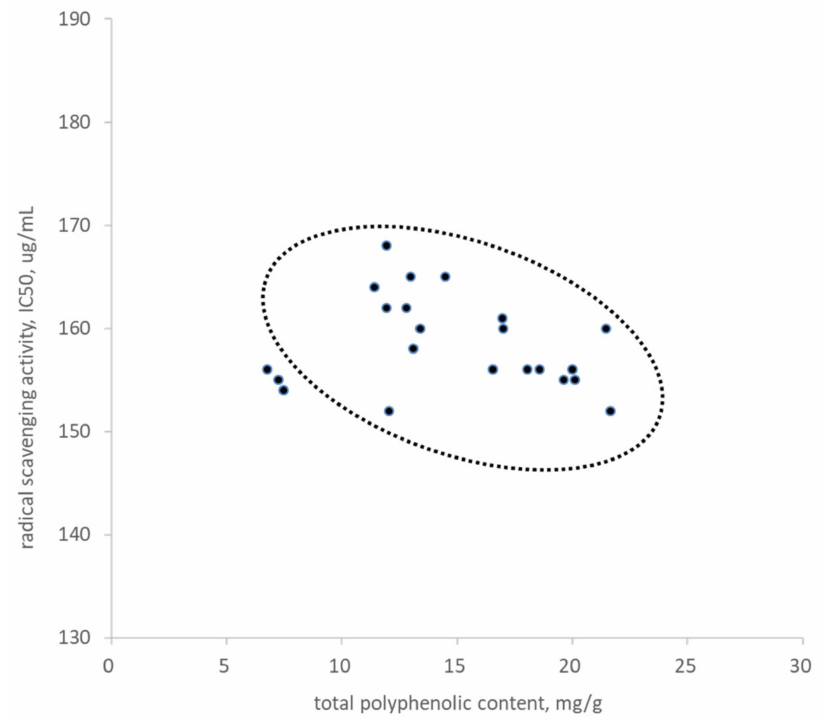
Figure 1. Total phenol content and scavenging effects of the hot-water extracts of 22 GHL extracts obtained from different provinces. Increasing total phenol content led to a proportional increase in radical scavenging activity, which was recoded with a decreased value of IC 50